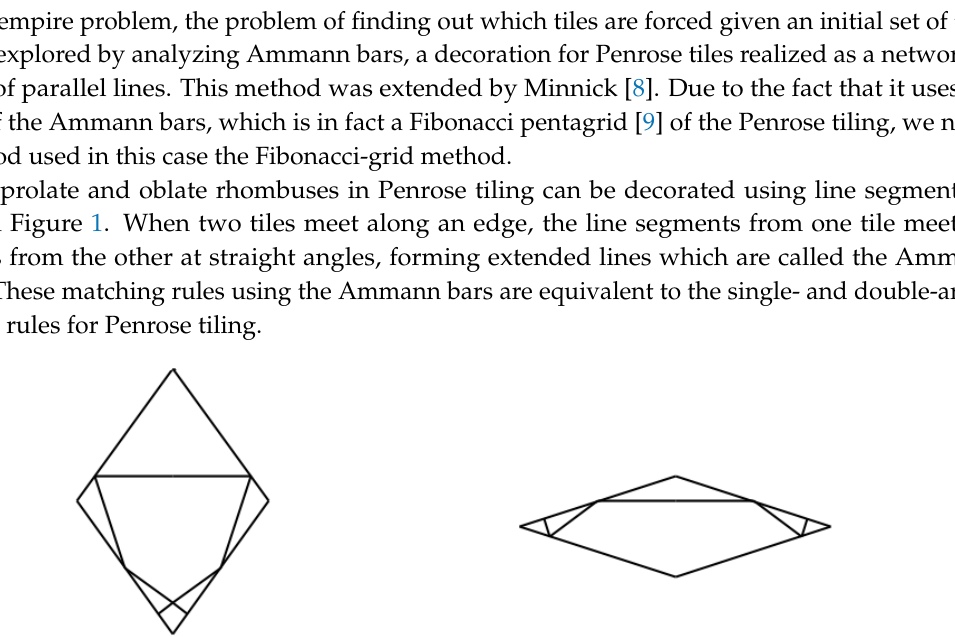
Figure 1. The prolate and oblate rhombuses in Penrose tiling decorated with segment